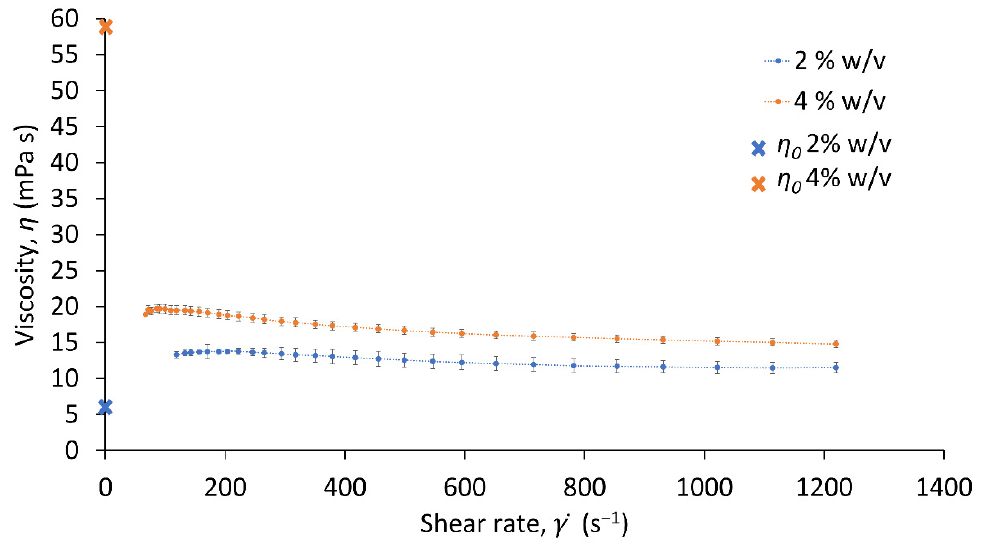
Figure 4. Shear rate against viscosity at 2% w / v starch and 4% w / v starch, measured by Bohlin viscometer, and viscosities at zero shear ( η 0 ) measured through Ostwald viscometer.